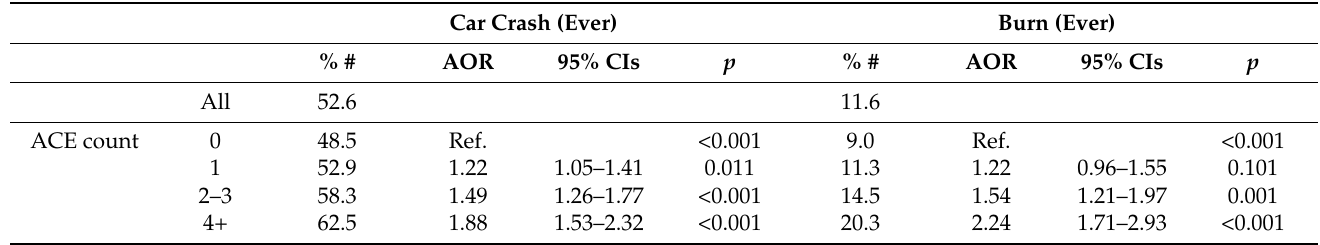
Table 2. Proportions ever reporting injury outcomes and adjusted odds ratios, by ACE count.